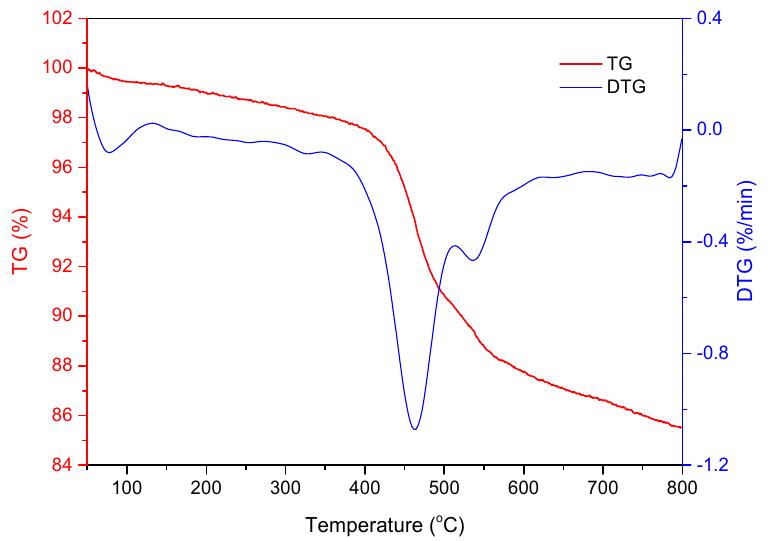
Figure 6. TG and DTG curves of the weight loss during oil shale pyrolysis. TG—thermogravimetry. DTG—differential thermogravimetric